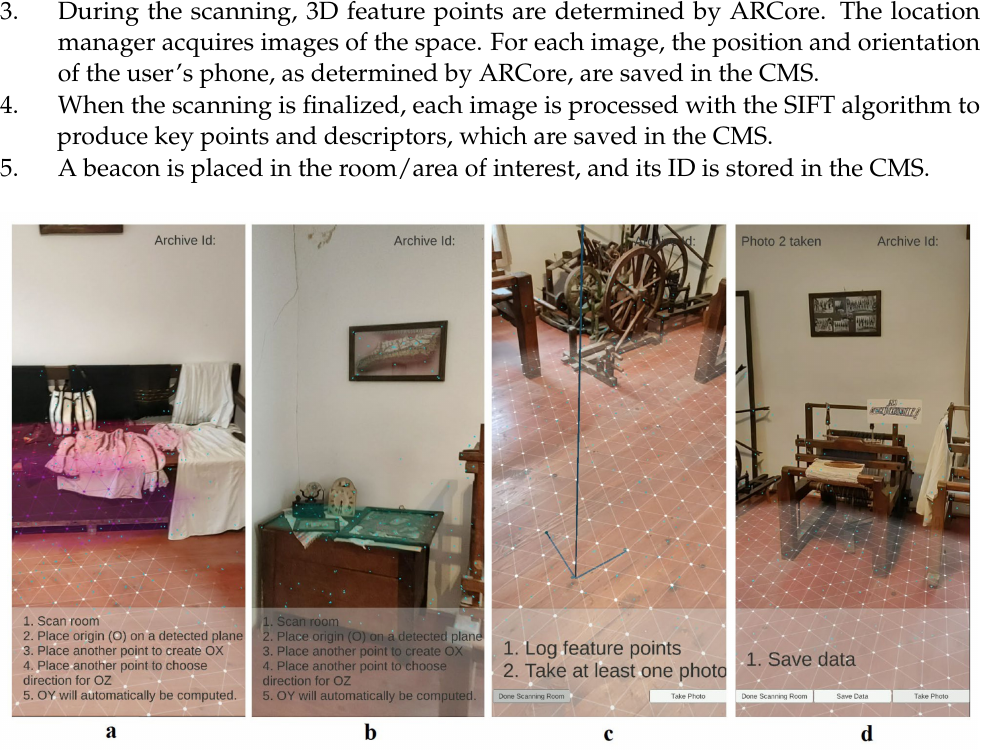
Figure 3. Workflow of the location manager application displaying the guidelines and several prominent planes: the floor and several planar surfaces of a bed ( a ), displaying detected feature points ( b ), displaying the user-defined coordinate system ( c ), and displaying a message that a photo has been taken ( d